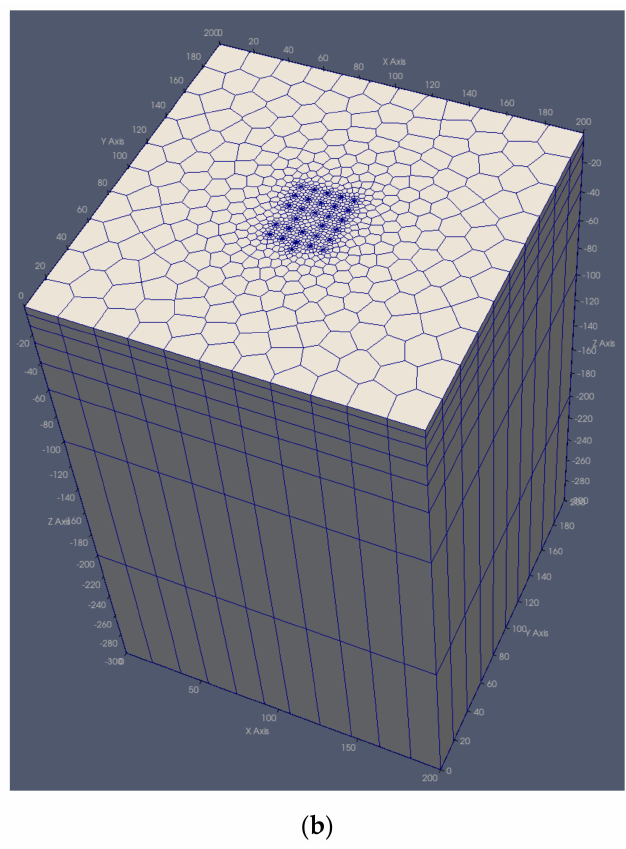
Figure 3. Two- and three-dimensional model domains. The two-dimensional model domain ( a ) is the same as a plan view of the three-dimensional model domain ( b ). The domain sizes of two- and three-dimensional models are 200 × 200 m (length × width) and 200 × 200 × 300 m (length × width × depth), respectively. There are 3621 and 29,150 elements and 10,004 and 108,894 connections in the two- and three-dimensional model domains,